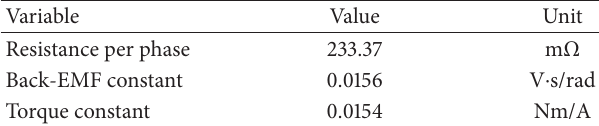
Table 1: Characteristics of the motor.